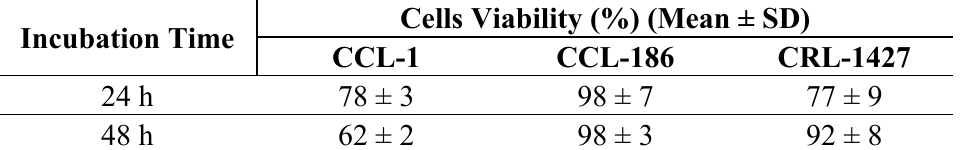
Table 2. Viability of CCL-1, CCL-186 and CRL-1427 cells following incubation for 24 and 48 h with the CM-hydrogel